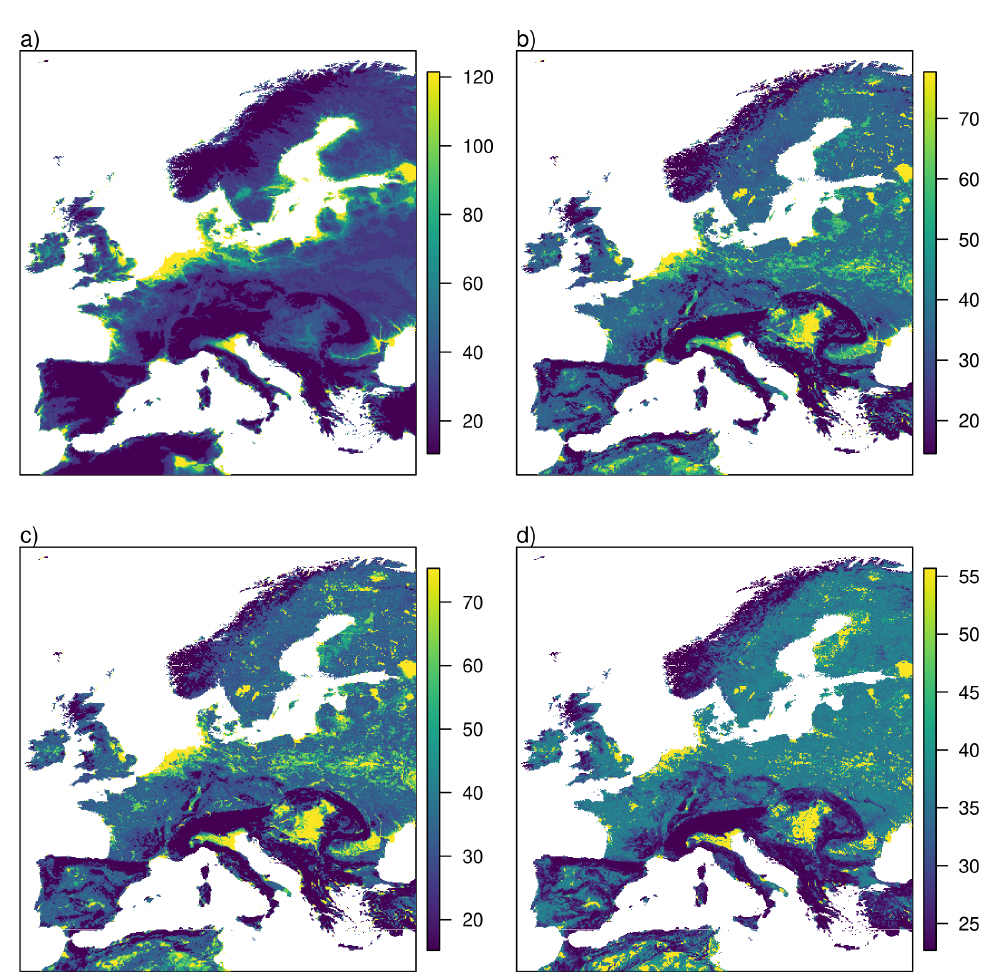
Figure 7. Local tornado occurrence rate per 100 years and 10,000 km 2 derived solely from orographic characteristics on 10km resolution: ( a ) elevation, ( b ) slope, ( c ) terrain roughness index and ( d ) sub-grid standard deviation of